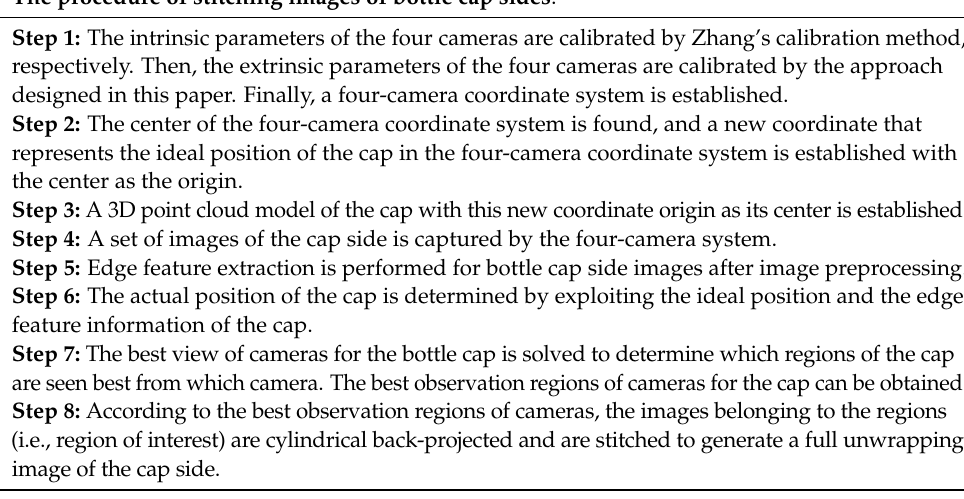
Figure 11. Structure of experimental system.